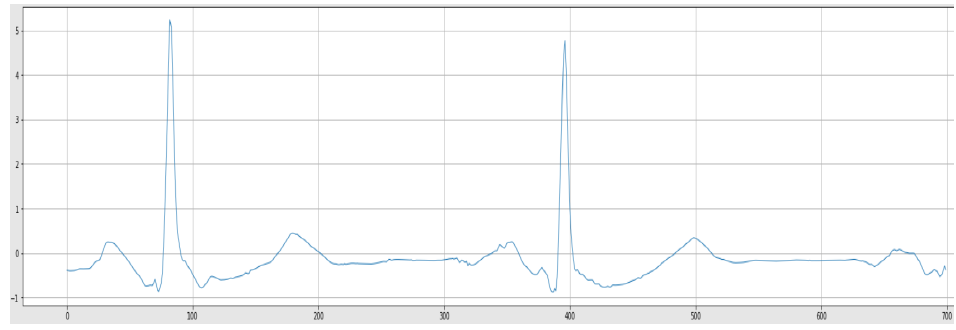
Figure 8. Normalized ECG Signal.